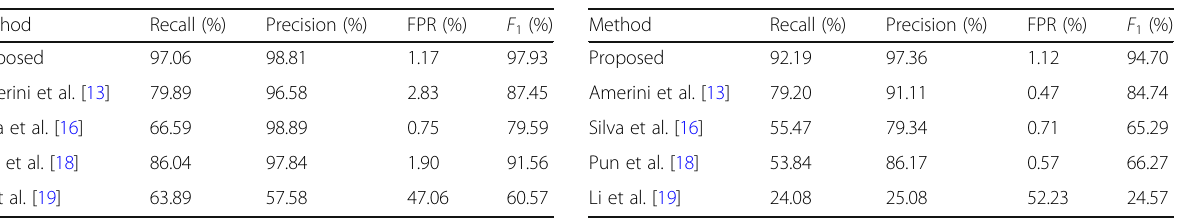
Table 5 Detected results for D1 dataset under rotation